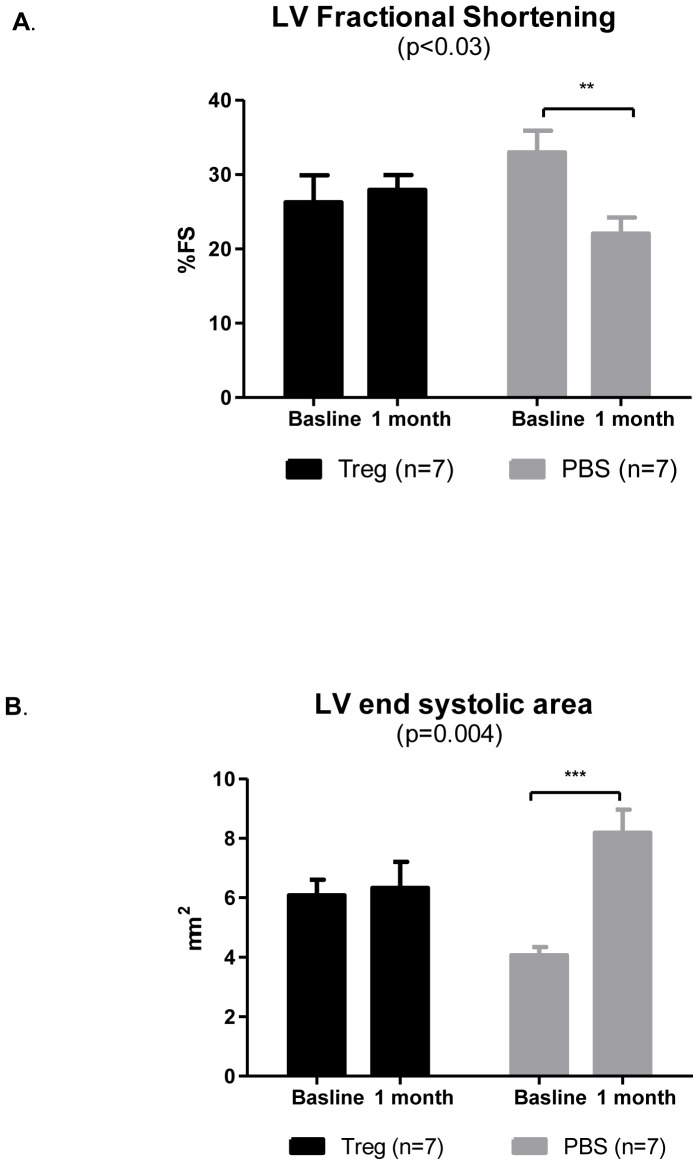
Adoptive transfer of Tregs improves cardiac function.(A) Treg-treated mice maintain fractional shortening, whereas control (PBS-treated) mice exhibit deterioration in this parameter. (B) Treg-injected mice exhibit no change in LVESA, whereas after 4 weeks the PBS-treated mice show a significant increase in LVESA compared to baseline. p based on Two-way repeated measures ANOVA; **p<0.007 and ***p<0.0005 based on 2-tail paired test.